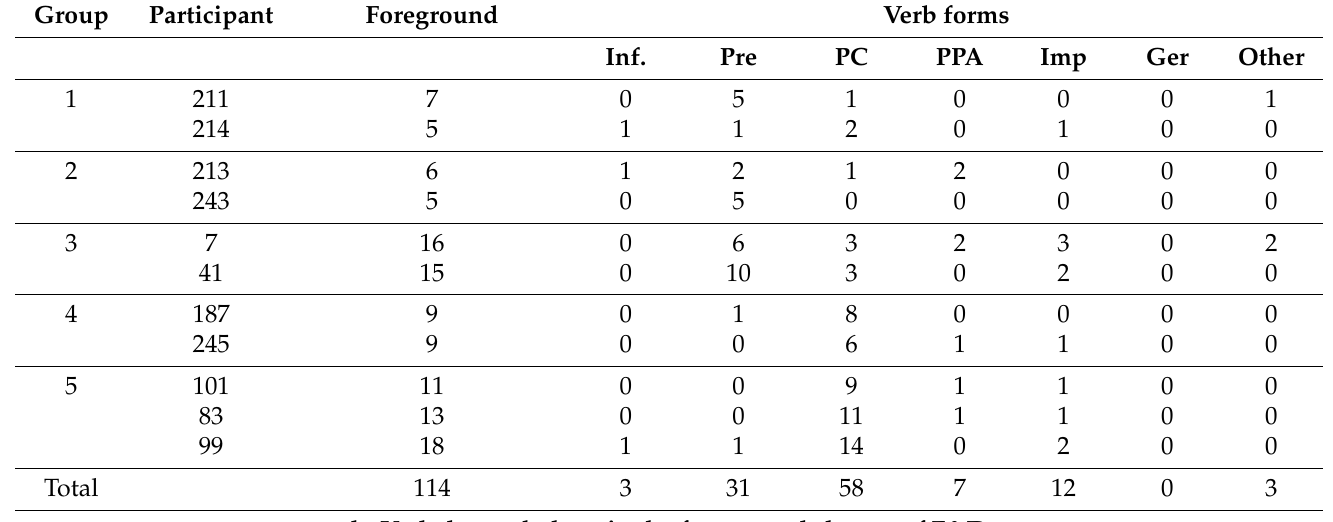
Table 4. Verbal morphology in foreground